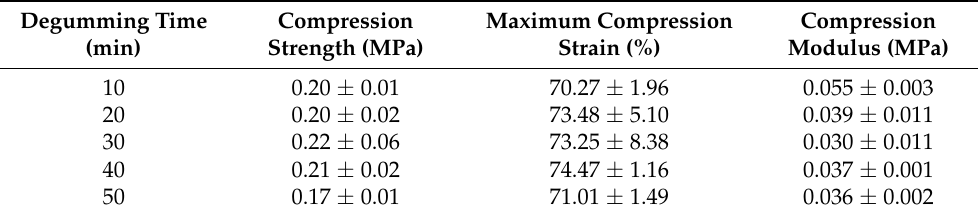
Table 2. Effect of silk fiber degumming time on the mechanical properties of pure SF